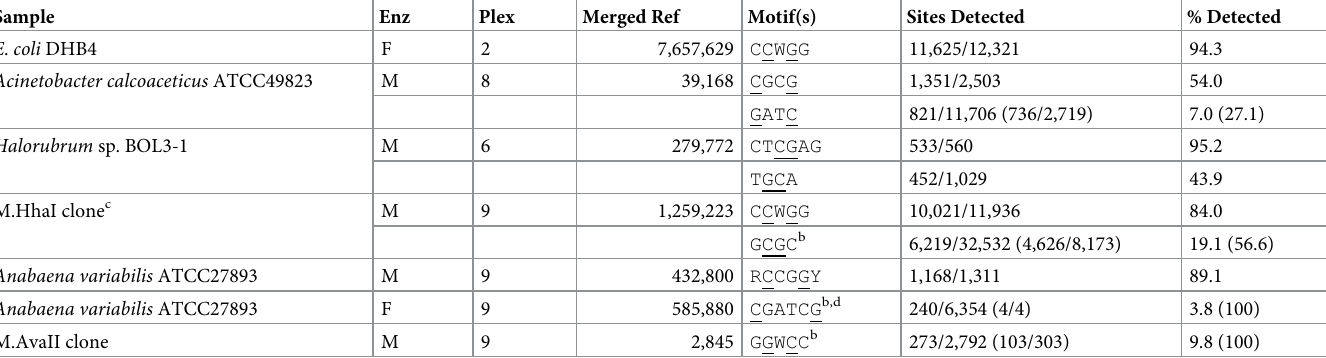
Table 6. Motifs determined using the Illumina MiSeq platform a